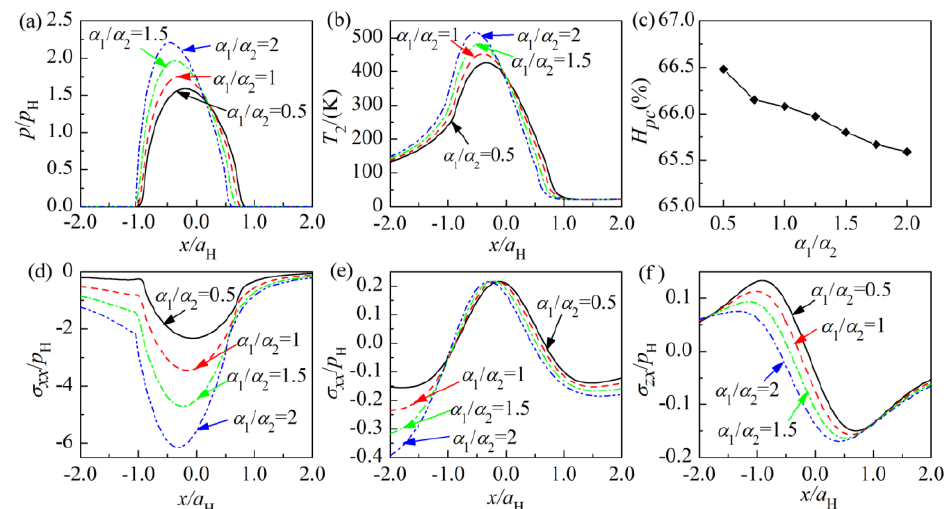
Figure 10. Effect of the coating thermal expansion coefficient α 1 on: ( a ) contact pressure along x axis, ( b ) surface temperature rise along x axis, ( c ) frictional heat partition coefficient, ( d ) σ xx on the surface, ( e ) σ xx at the base of the coating, ( f ) σ zx on the interface.